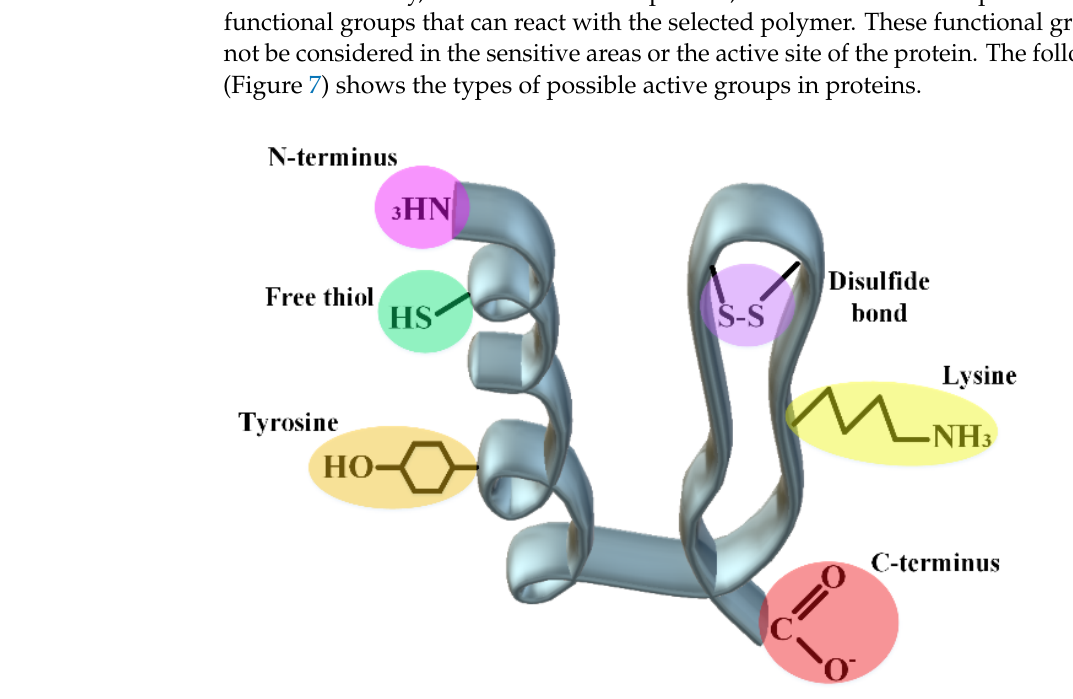
Figure 7. Introducing several active groups on the surface and inside a hypothetical protein structure to introduce desired covalent